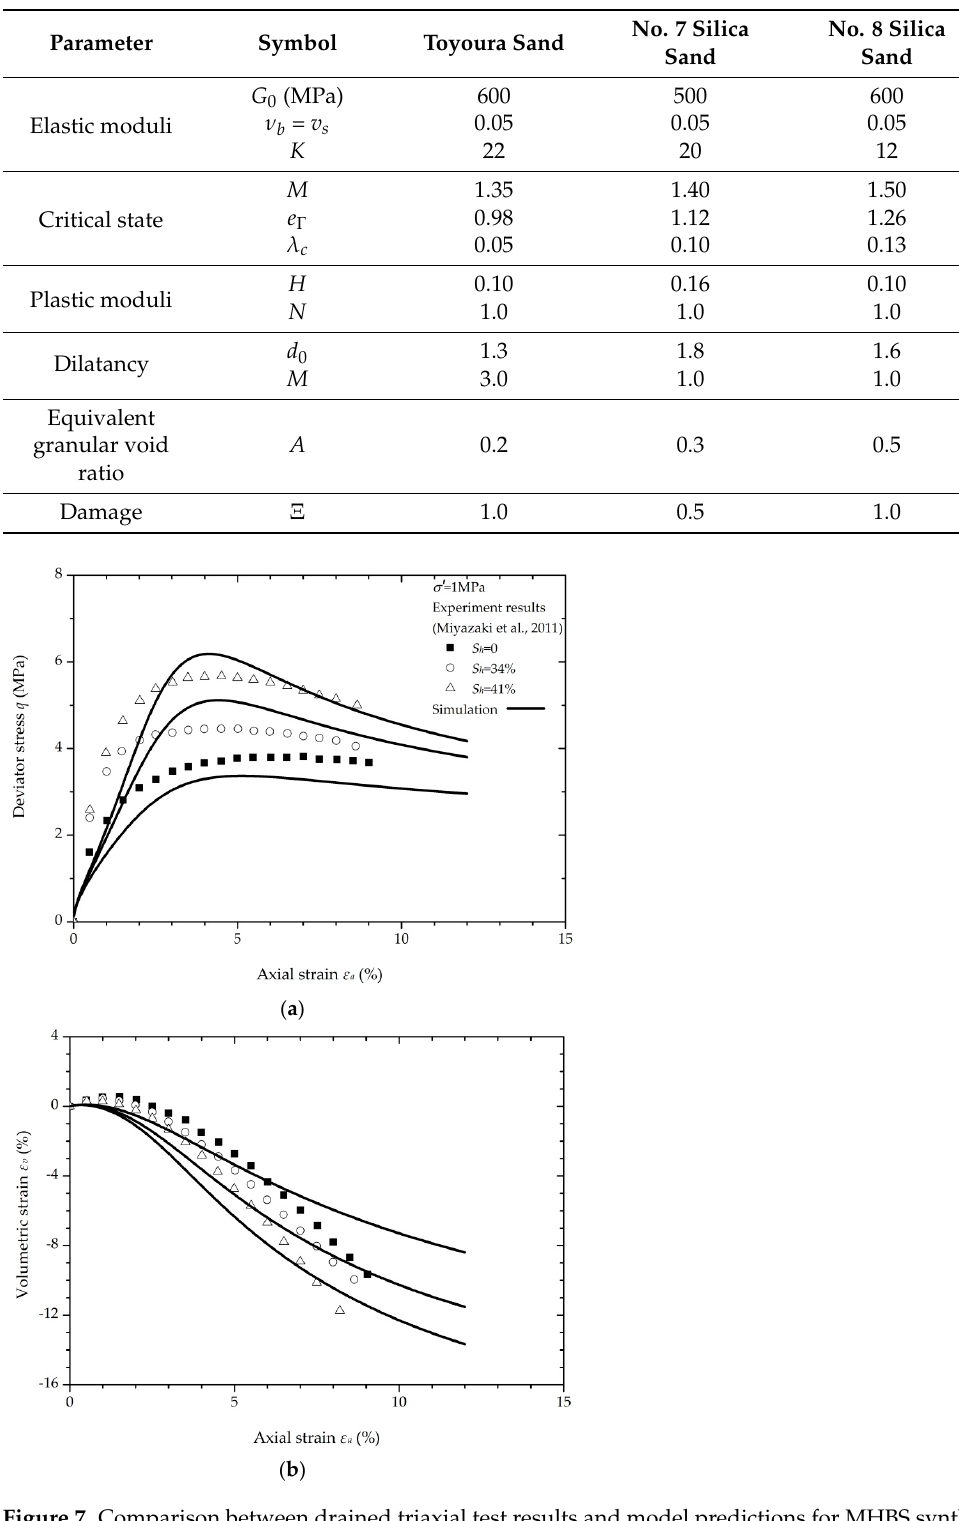
Table 2. Parameters for MHBS synthesized from different sands.